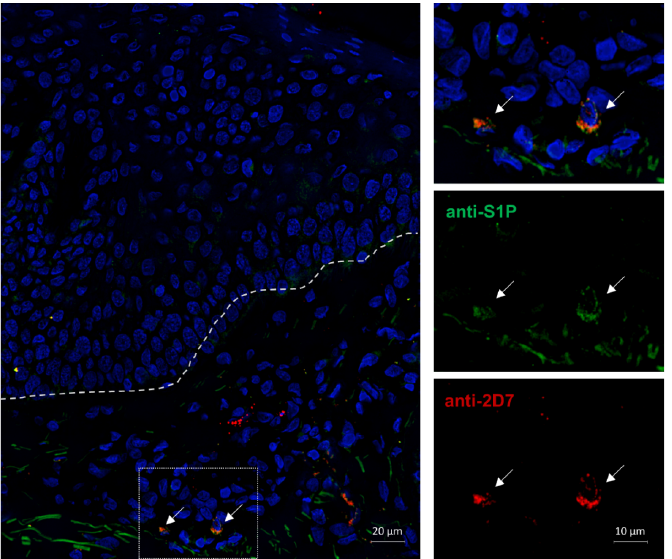
Figure 6. S1P immunofluorescence staining of S1P positive basophils in AD skin. AD = atopic dermatitis. A lesional AD skin biopsy was fixed in 4% PFA, and a double immunofluorescence staining was performed. Antibodies against the basophil marker 2D7 (red) and the lipid S1P (green) were utilized. Nuclei were stained with DAPI (blue). The image was acquired through fluores- cence microscopy at 40 × magnification. The dotted line marks the junction of the epidermis (top) and dermis (bottom), and arrows point to intradermal basophils. Basophils in the dermis possess intracellular